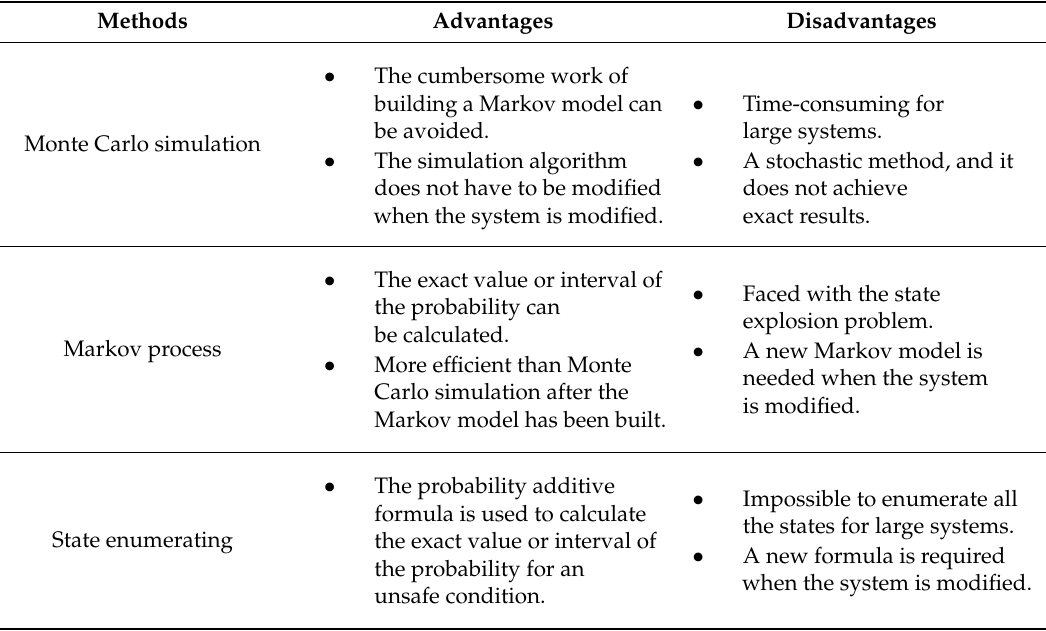
Table 3. Comparison of the three